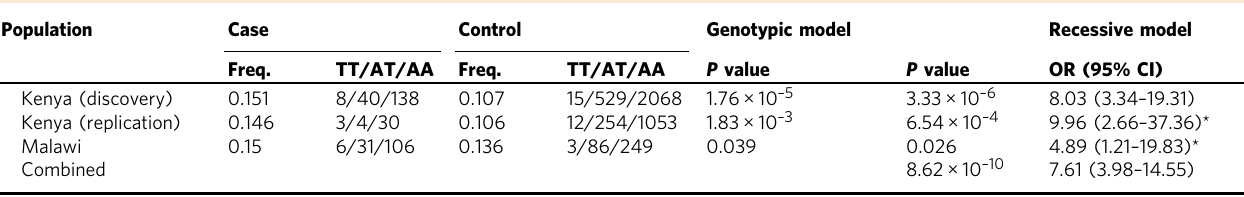
Table 1 Association of rs13390936 with NTS bacteraemia in African children Population Case Control Genotypic model Recessive model